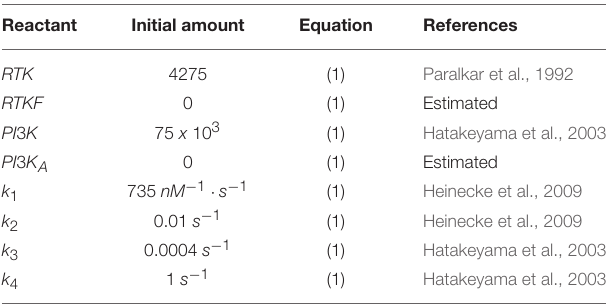
TABLE 4 | Initial amounts of each reactant as well as the reaction rates obtained from literature.